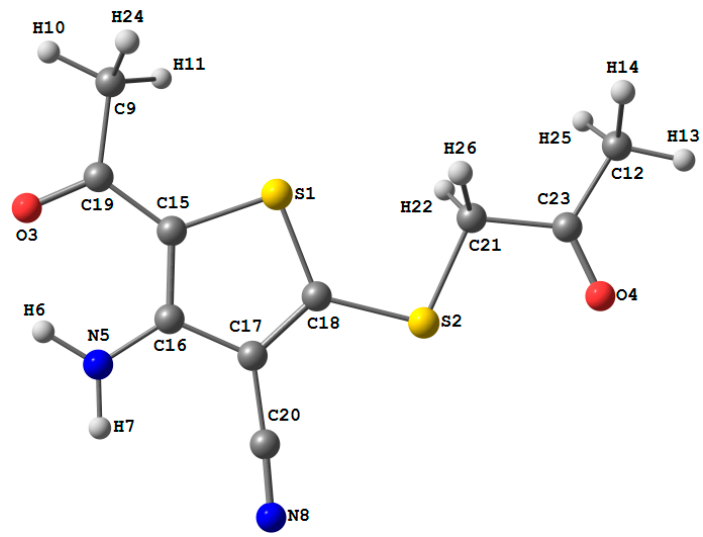
Figure 3. The optimized molecular structure of compound 4 .